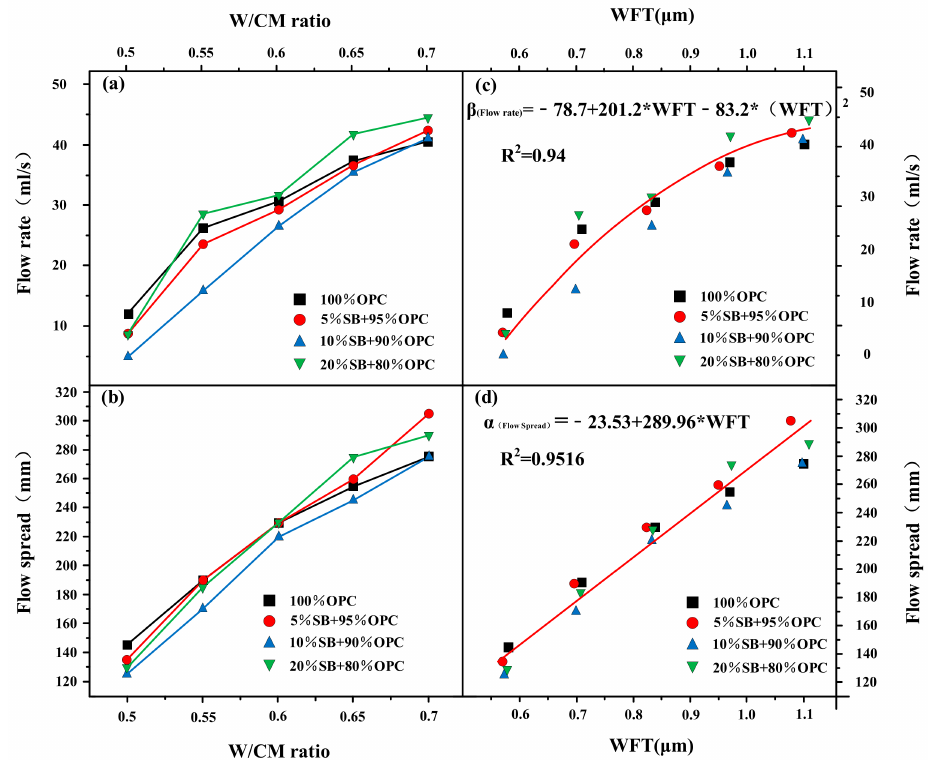
Figure 5. Flow rate and flow spread versus W/CM ratio ( a , b ) and WFT ( c , d